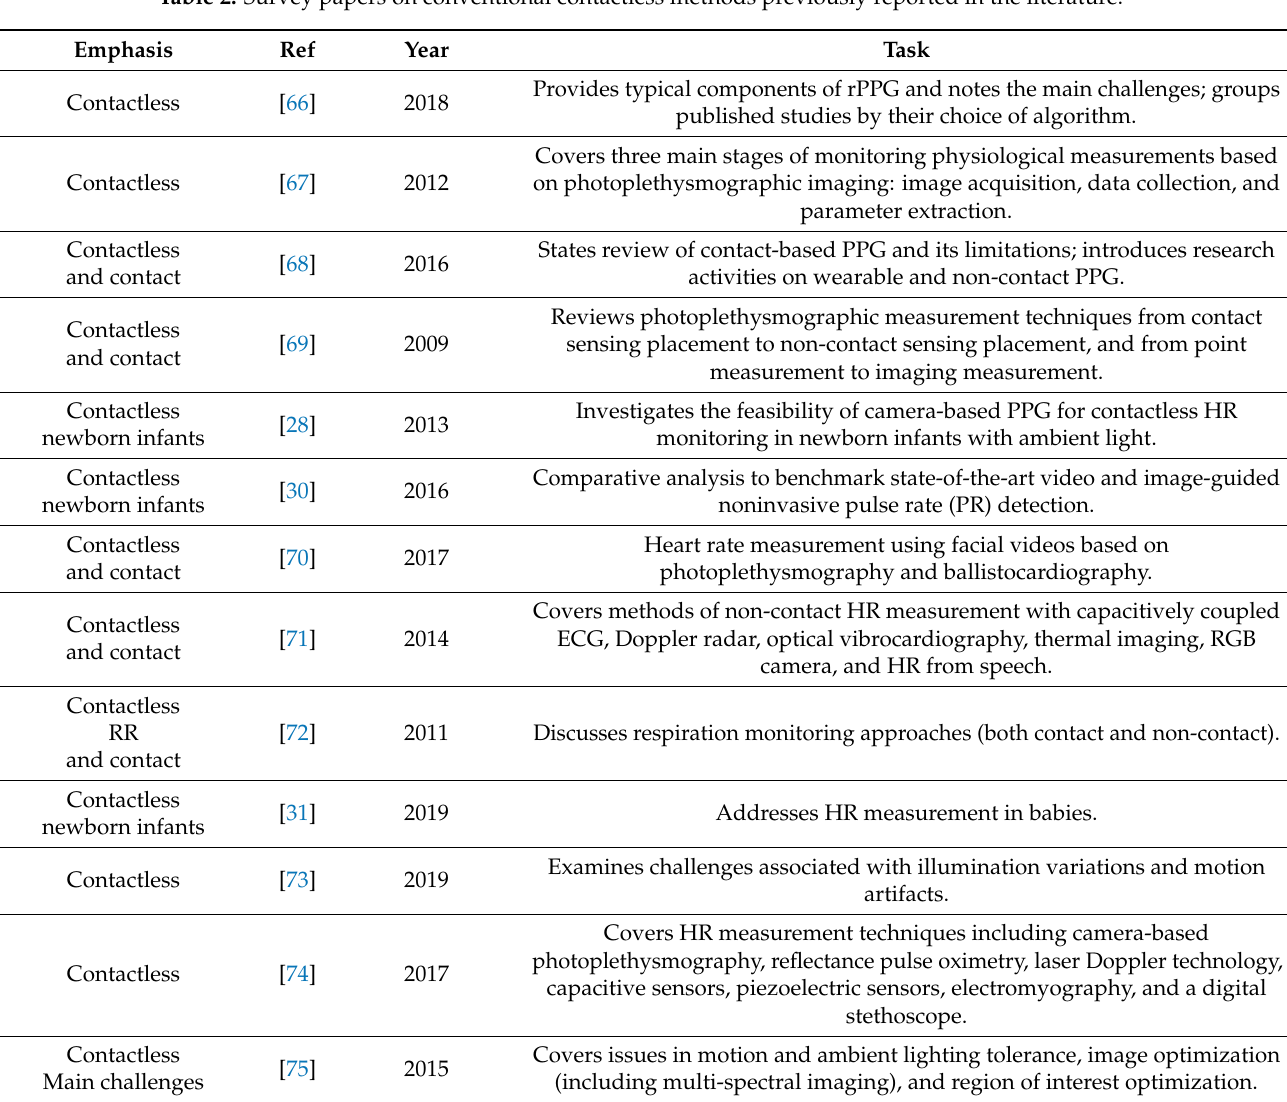
Table 2. Survey papers on conventional contactless methods previously reported in the